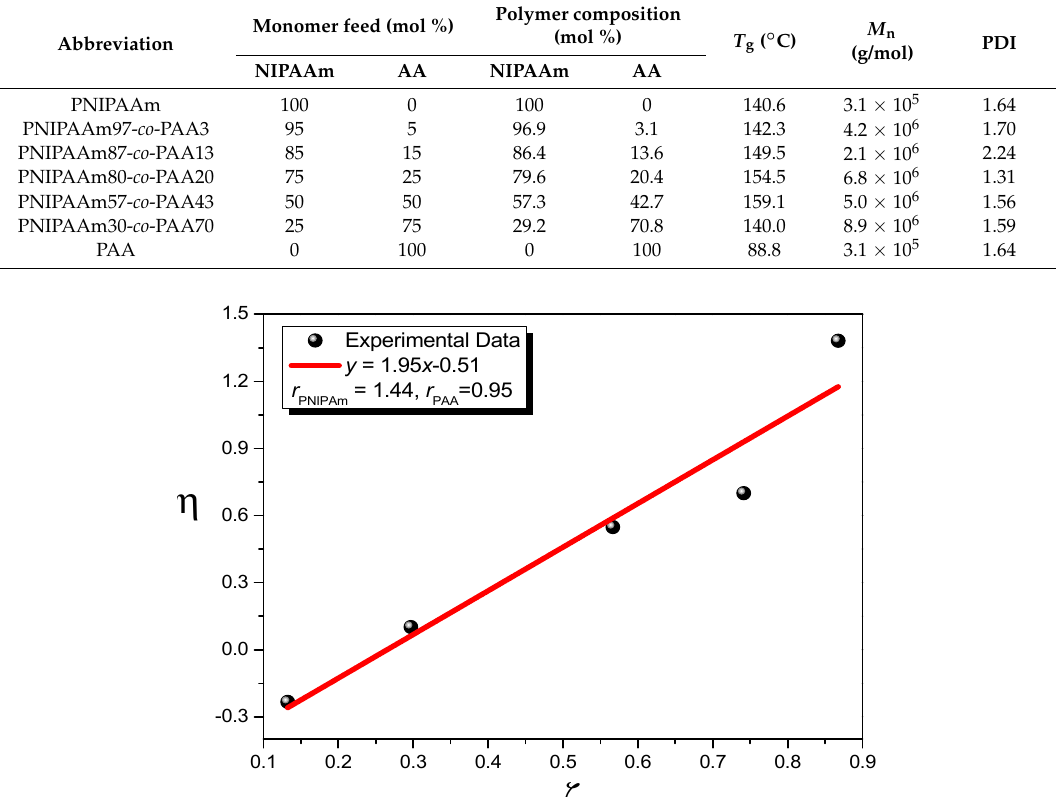
Table 1. Characteristics of the PNIPAAm- co -PAA copolymers used in this study. Table 1 Characteristics of the PNIPAAm- co -PAA copolymers used in this study.